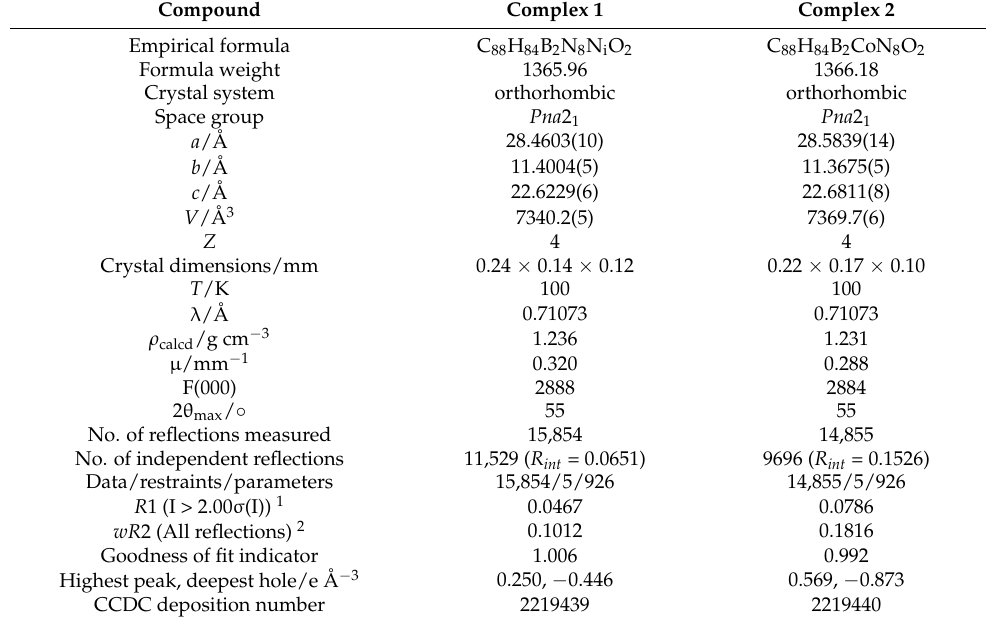
Table 1. Crystallographic data and refinement parameters of 1 and 2